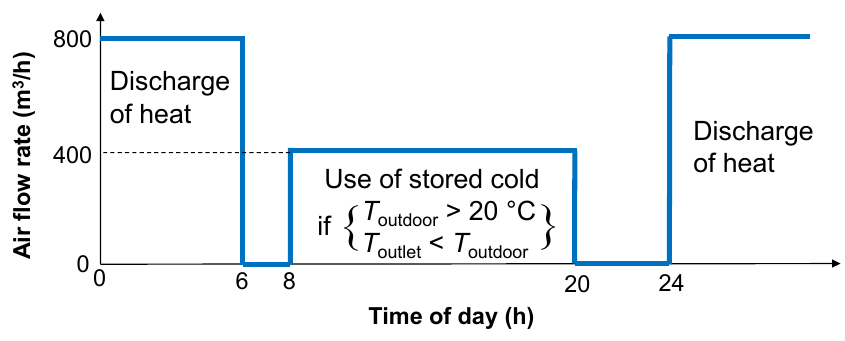
Figure 1. Operation of cold storage.